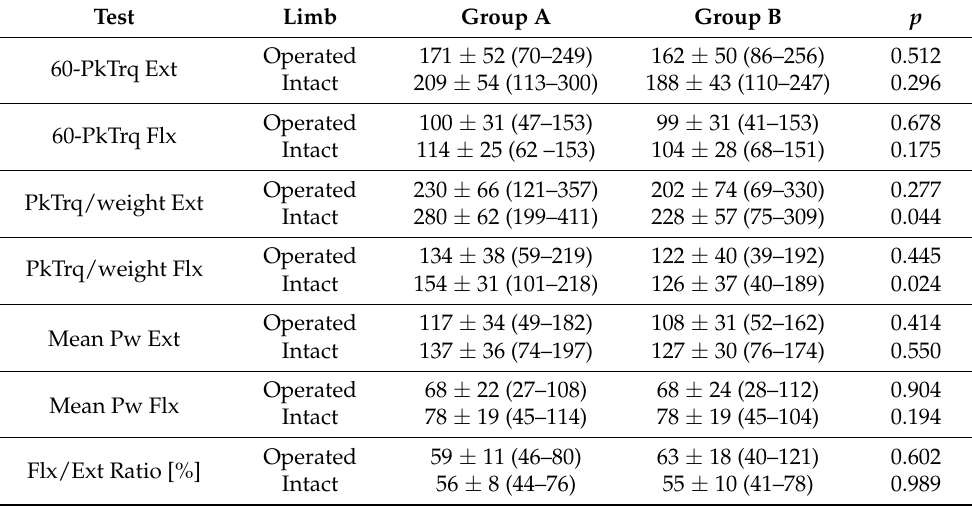
Table 3. Absolute and relative isokinetic strength in ACL patients. Values are presented as median ± standard deviation. The minimum and maximum values are given in brackets. p values are indi- cated. PkTrq—peak torque; Ext—extensors muscles; Flx—flexors muscles; Pw—peak torque/body weight ratio.